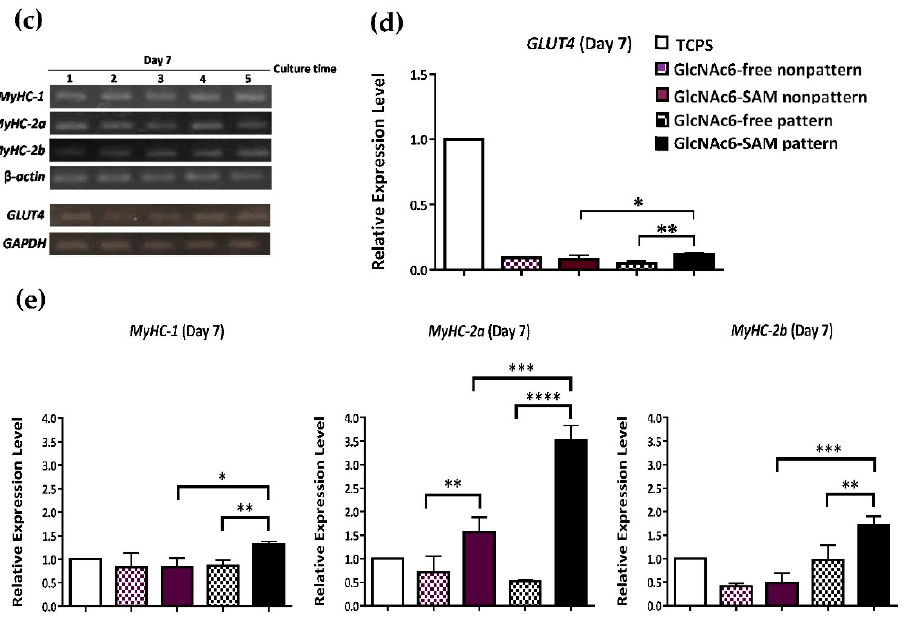
Figure 2. Effects of micropatterns and non-patterns with or without GlcNAc6-SAMs on differentiated C2C12 cells during myotube development. ( a ) Myoblast differentiation proceeds in stages from Days 3–7 under culture medium without switching to differentiation medium on the GlcNAc6-SAM pattern (1000 µm); ( b ) Confocal images of differentiated myoblasts on the GlcNAc6-SAM pattern (500 µm). Actin filaments were stained green, and nuclei were visualized with DAPI (blue) after seven days of culture. Myotubes are labeled with white arrows. Scale bars represent 200 µm ( c – e ). mRNA expression levels of GLUT4 and three isoforms of myosin heavy chains ( MyHCs ) in myoblasts after seven days of culture. The expression level was normalized to GAPDH and β -actin for GLUT4 and MyHCs , respectively. Representative polymerase chain reaction (PCR) products of target genes were determined on 2% agarose gels by ethidium bromide staining. Lane 1: tissue culture polystyrene (TCPS); Lane 2: GlcNAc6-free non-pattern; Lane 3: GlcNAc6-SAM non-pattern; Lane 4: GlcNAc6-free pattern (500 µm); and Lane 5: GlcNAc6-SAM pattern (500 µm). Asterisks signify a significant difference from the appropriate control value. Values are the mean ± SEM, n = 9 per each sample; * p < 0.05, ** p < 0.01, *** p < 0.001 and **** p < 0.0001.